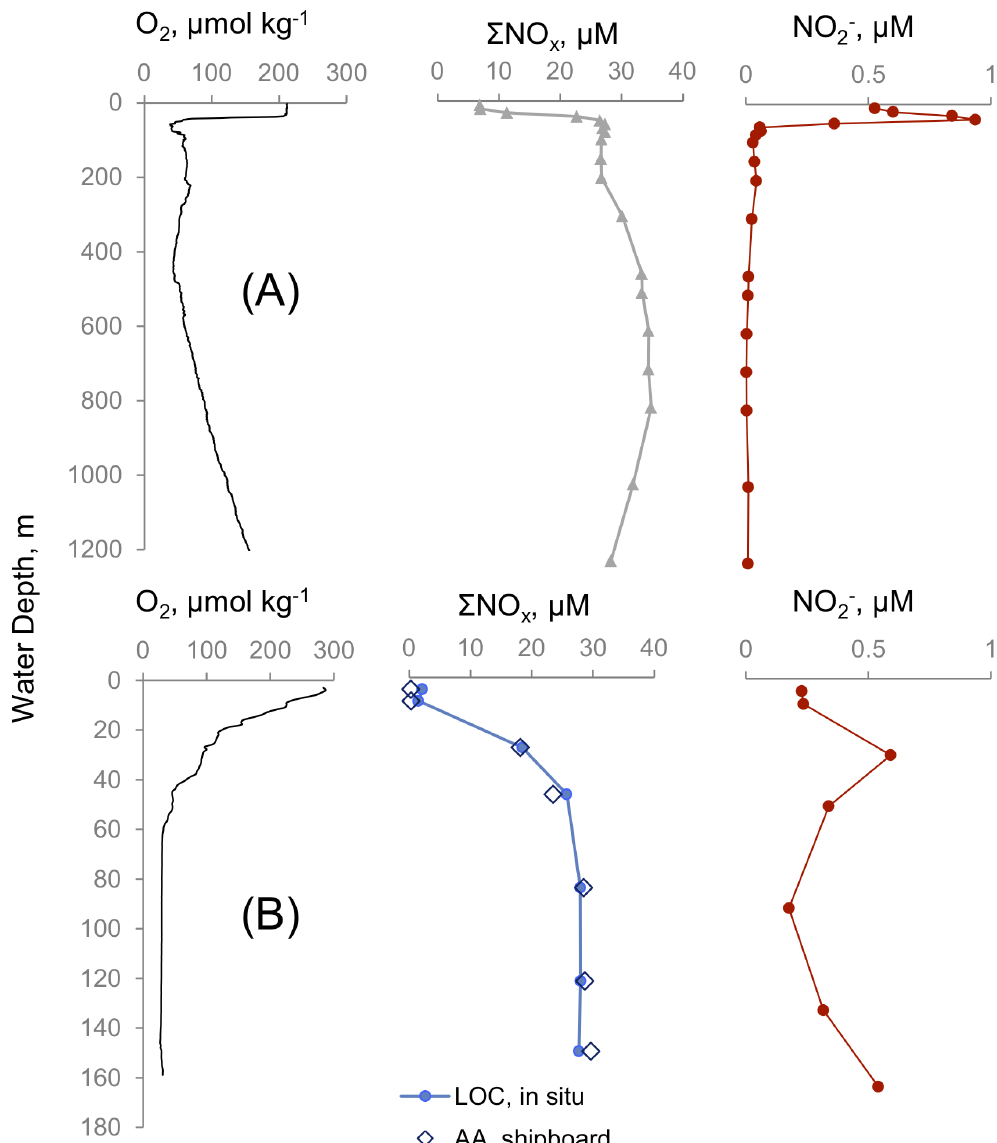
Fig 1. Water column chemistry in two stations in the Mauritanian OMZ (A) Water column profile of oxygen, NO 3- + NO 2- ( Σ NO x ) and NO 2- during a CTD cast (#15) at 1200 m depth. Both casts were conducted on June 12, 2014 at 16°48.32' W and 18°09.00' N. (B) Profiles from CTD cast #16 at a depth of 160 m where a LOC sensor was also attached to the CTD frame. “ AA ” stands for autoanalyer. These profiles were obtained on June 12, 2014 at 18°14.0' W and 16° 31.0'